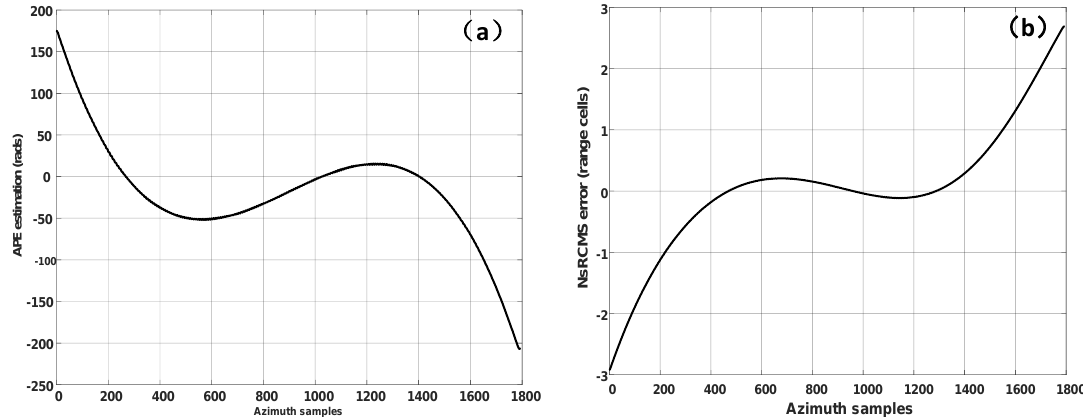
Figure 7. Estimated ( a ) APE error function and calculated ( b ) NsRCM error function for compensation.